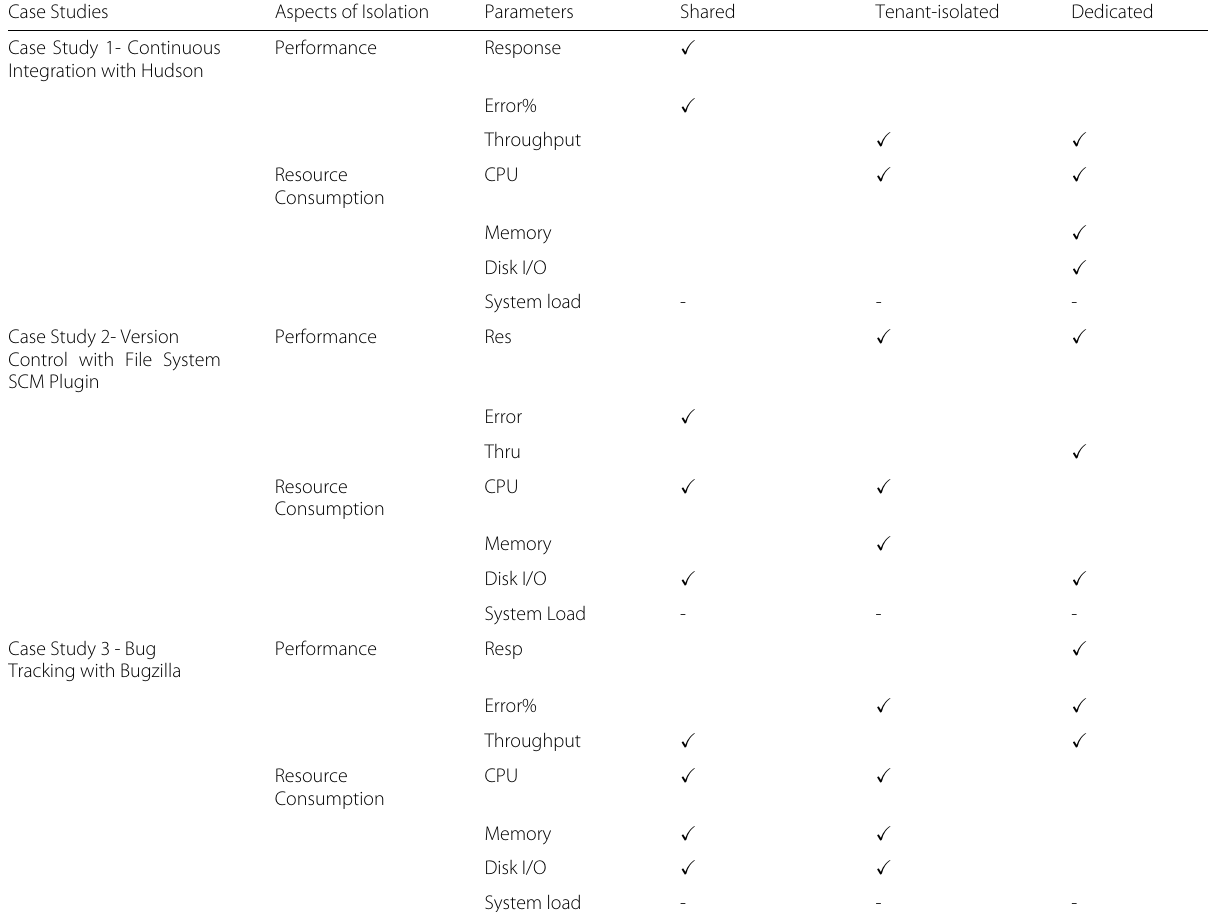
Table 9 Recommended Patterns for optimal deployment of components Case Studies Aspects of Isolation Parameters